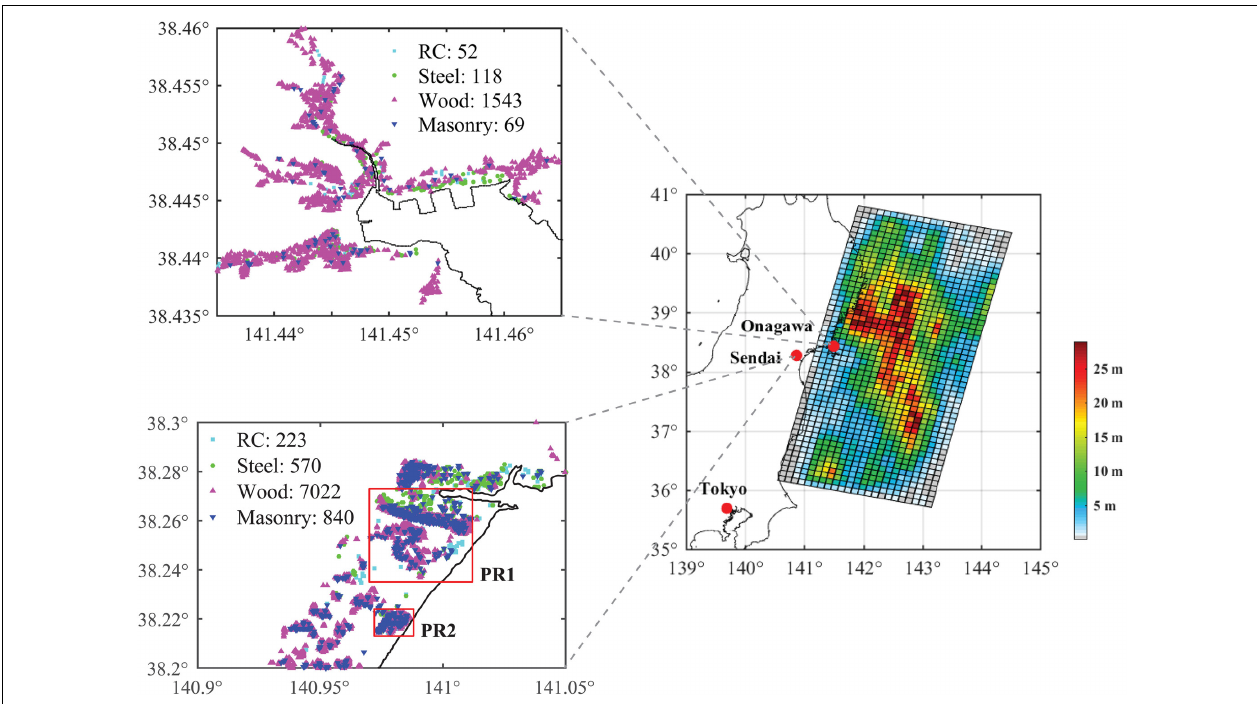
FIGURE 2 | Building portfolios of Sendai and Onagawa. An illustrative earthquake slip model of M w 9.0 events is displayed in the regional map of Tohoku,